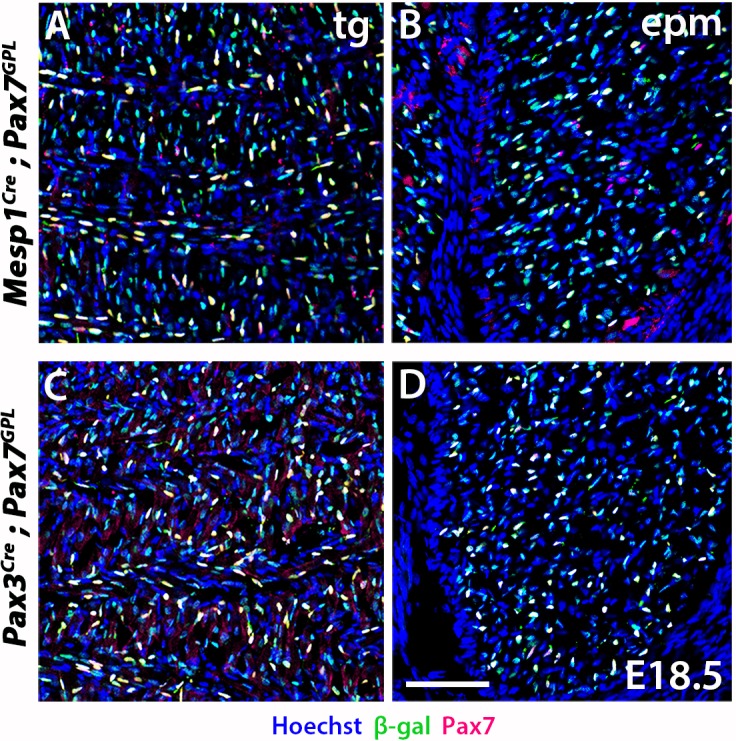
Mesp1 and Pax3 lineage tracings in somitic neck muscles using the Pax7GPL reporter.(A–D) Immunostainings for β-gal and Pax7 on coronal cryosections of Mesp1Cre;Pax7GPL and Pax3Cre;Pax7GPL at E18.5 (n = 2 each condition). Note the white/yellow cells indicating colocalization of both markers. epm, epaxial muscle; tg, tongue. Scale bar in D for A-D 100 µm.